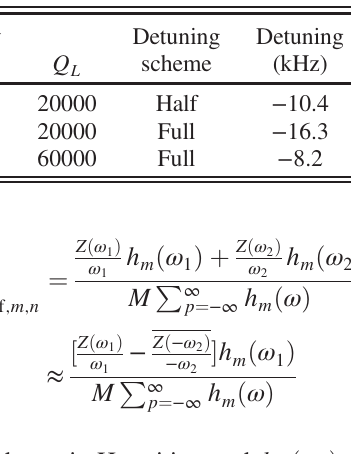
TABLE I. Maximum value of j Λ n j over all n caused by the impedance of the eight cavities at the fundamental. OTFB Off.